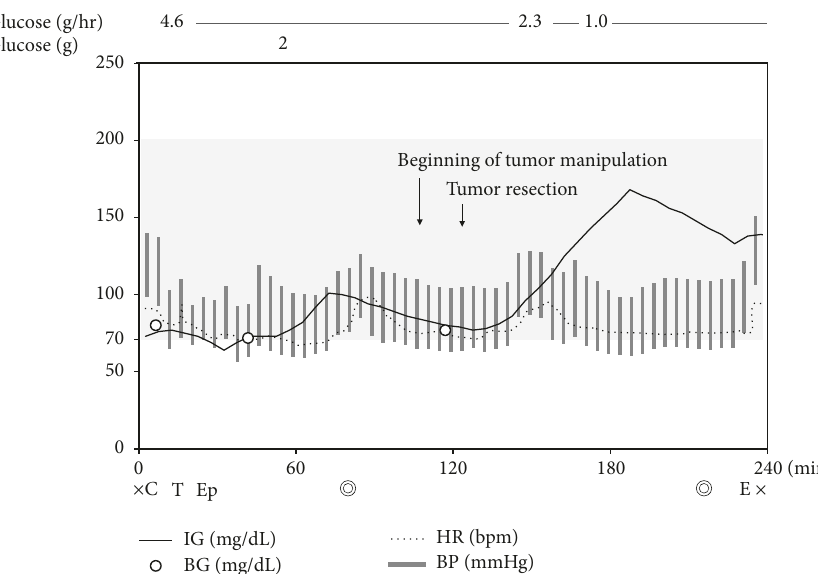
Figure 1: Changes of interstitial glucose level measured by the subcutaneous continuous glucose monitoring system (IG) (black line), blood glucose level (BG) (white circle), and hemodynamics during general anesthesia for resection of insulinoma. The light grey zone indicates the normal value of casual BG (70–200 mg/dL). The dotted line indicates heart rate (HR) and the grey bar indicates blood pressure (BP). C indicates calibration of the subcutaneous continuous glucose monitoring system; T: tracheal intubation; Ep: epidural catheterization;